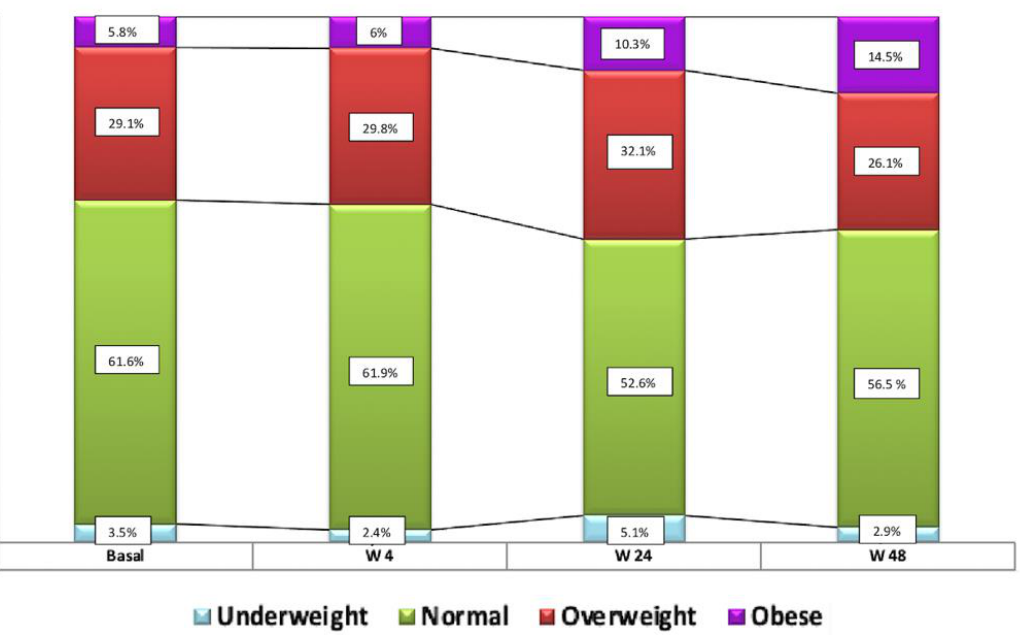
Figure 3. Distribution of patient weight classification by BMI at baseline and weeks 4, 24, and 48.